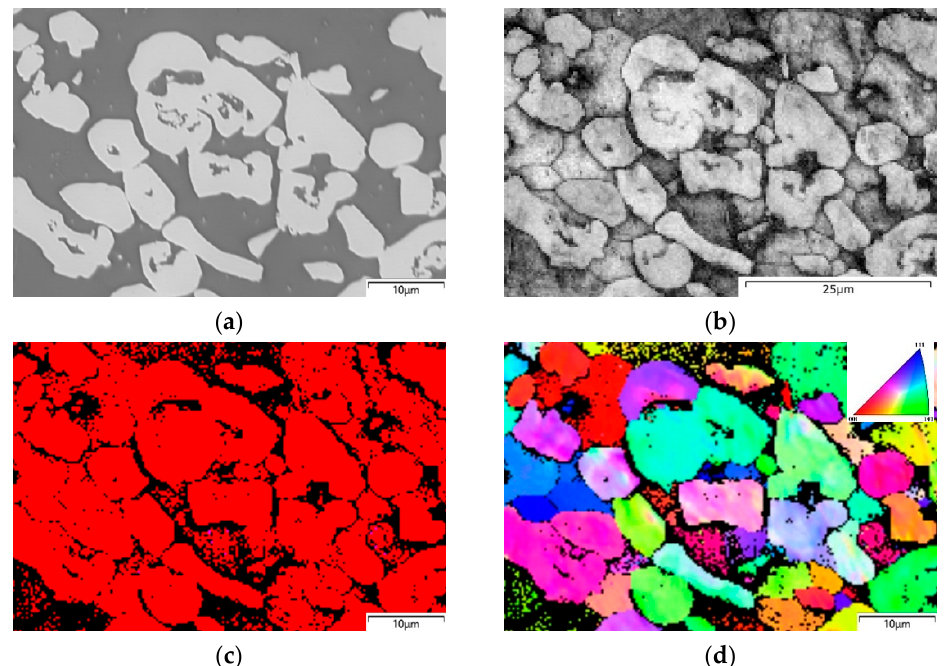
Figure 13. ( a ) A BSE image and ( b – d ) respective EBSD maps of the matrix and second-phase particles in Re 0.3 TaTiZr after compression deformation at 1000 °C with a true strain of 0.69. ( b ) Band contrast map, ( c ) phase map (BCC is red), and ( d ) IPF map in the compression direction of the BCC matric phase and BCC particles. The IPF color-coding map is shown as an insert in ( d ). The compression direction is vertical.